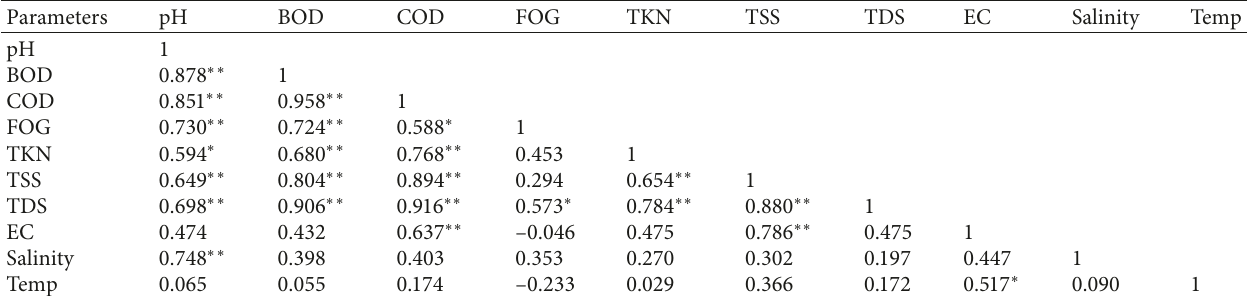
Table 7: Correlation coefficients of various pollutants from aeration